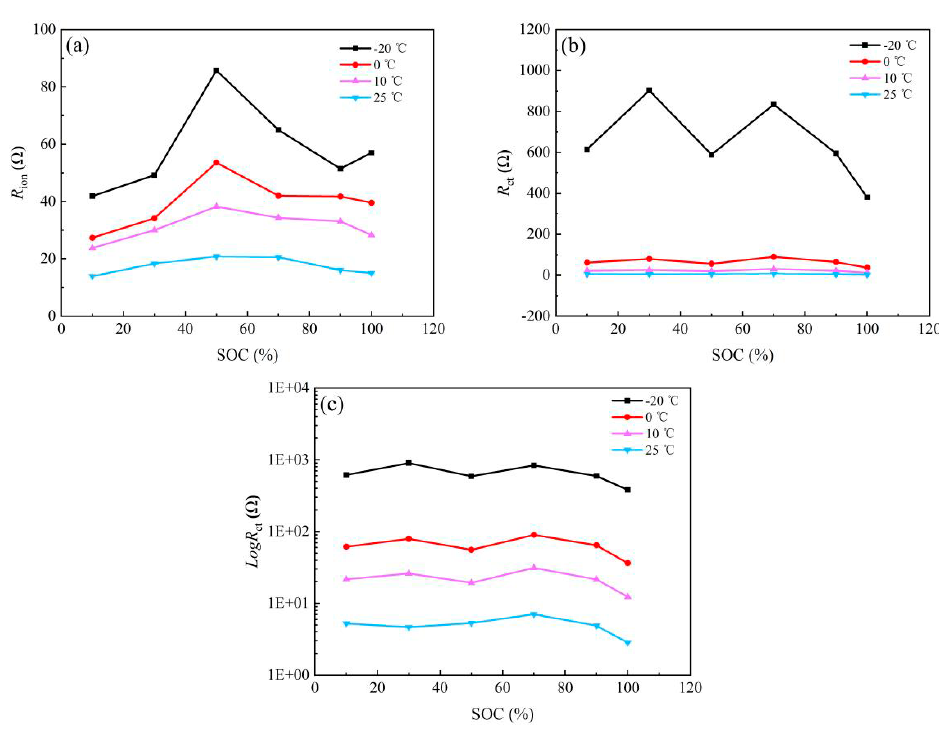
Figure 10. Plotting of anode in ( a ) R ion and ( b ) R ct ( c ) Log R ct. Figure 11 shows the variation of R ion and R ct with the SOC of the NCM523 electrode at different temperatures. The variation of R ion of the NCM523 electrode with the SOC at different temperatures is similar to that of the graphite electrode, but its value is much lower. In general, at each temperature, the R ct of the NCM523 electrode first decreases and then increases with the SOC, also aligning with Equation (5). In other words, to re- alize fast charging and discharging, the working SOC of the NCM523 electrode should be controlled at around 50% SOC, especially at low temperatures.